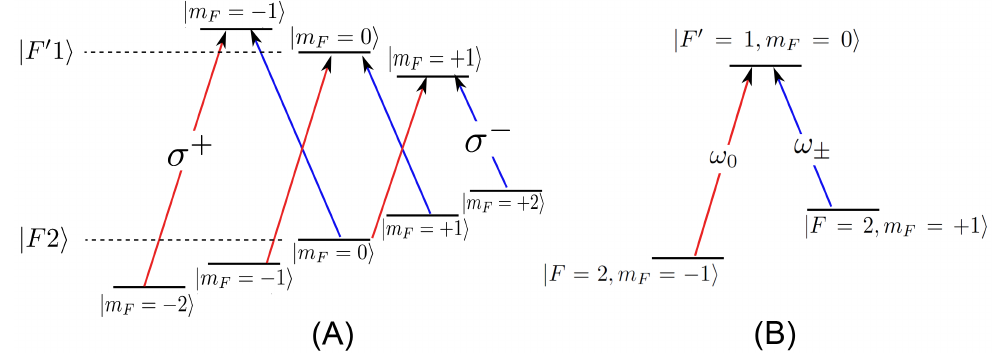
Figure 4. In ( A ) multiple Λ configurations form when a magnetic field is applied to 87 Rb : F = 2 → F (cid:48) = 1. The frequency shift responses to the applied magnetic field of the Zeeman sub-levels are 0.70 MHz/G and -0.23 MHz/G for F = 2 and F ′ = 1 energy levels respectively. ( B ) is the Λ configuration where the CPT is based in this work; ω 0 is the unmodulated coupling beam, and ω is the modulated probe beam. Application of a 1 V peak voltage with 0.05 V step triangular waveform to the 2nd- AOM driver results in ω being detuned around the 87 Rb : F = 2, m F = + 1 F (cid:48) = 1, | (cid:105) → | ± transition, and, at exact zero detuning, a CPT signal was obtained as shown in m F = 0 (cid:105) Figure 5. The CPT signal was found to have a full width half maximum (FWHM) of 168 Hz at an ambient temperature of 19 ◦ C. The dispersion like signal of the resonance peak, which is the measured first derivative of the CPT signal, was found to have a slope of 63 Hz. This corresponds to a magnetic field of 9.0 nT for the above Λ -type CPT, (since the state has F 2 | (cid:105) 0.7 MHz shift per G as shown in Figure 4). This is the smallest shift in frequency and hence the magnetic field that can be detected for our present